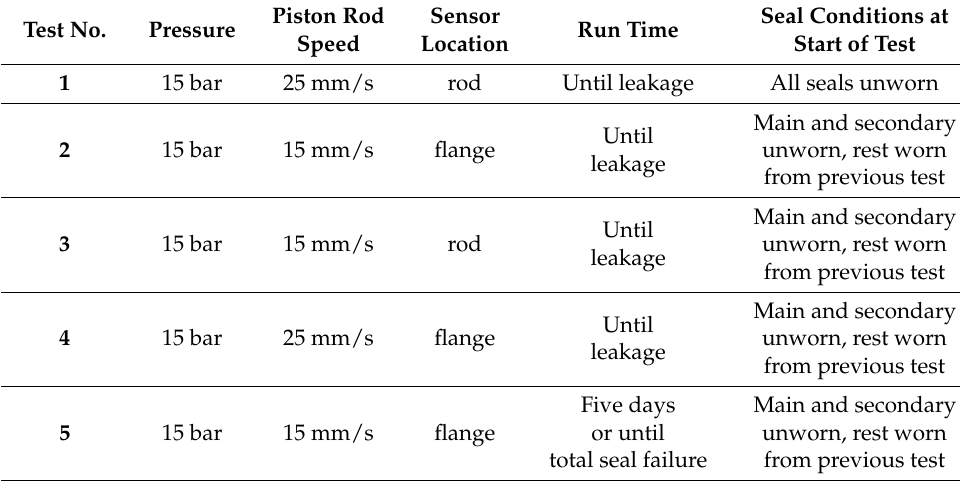
Table 2. RTF test conditions.